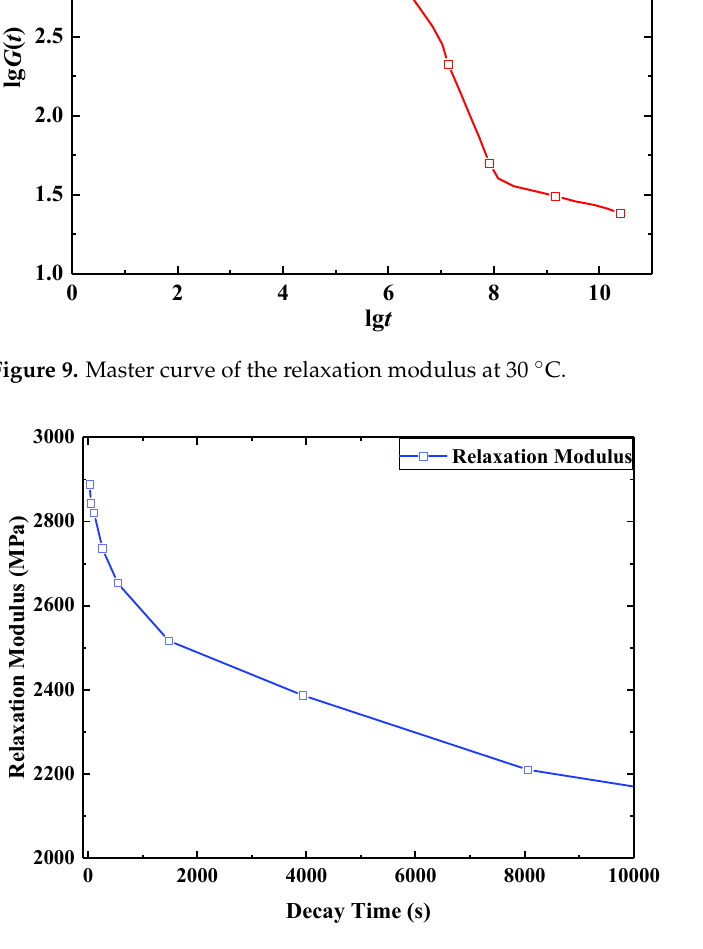
Figure 10. Relaxation modulus at the 30 °C. Table 2. Shift factor values at different temperatures with a reference temperature of 30 ◦